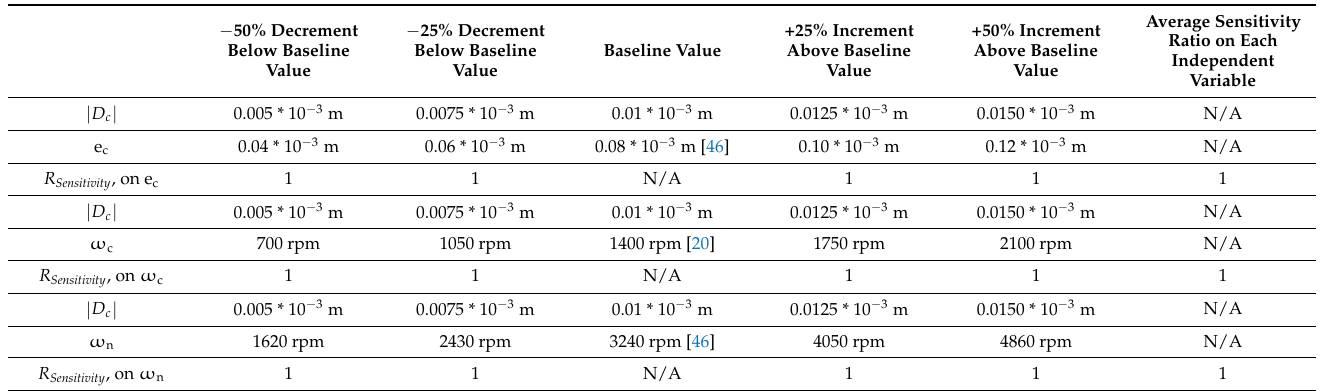
Table 1. Sensitivity analysis of the analytical model of dynamic displacement, | D c | .